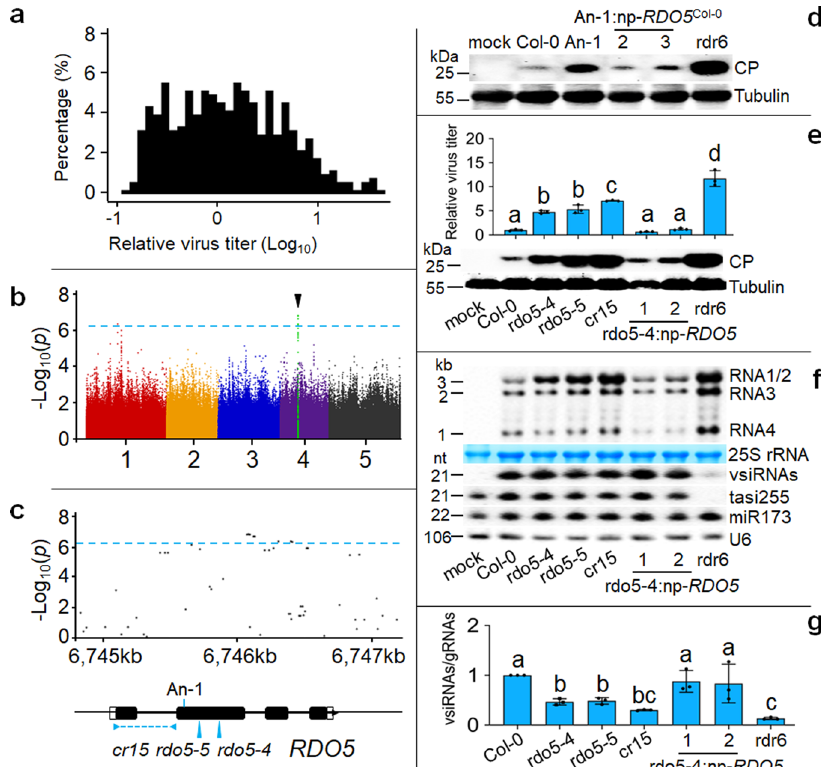
Fig. 1 RDO5 confers quantitative virus resistance. a A nearly normal distribution of CMV- Δ 2b accumulation levels in 496 Arabidopsis accessions after ELISA readings at 2 weeks post-infection were log-transformed. b Manhattan plot for GWAS mapping of the quantitative resistance phenotype to CMV- Δ 2b infection. Five A. thaliana chromosomes were depicted in different colors. The horizontal dash-dot line corresponds to the signi fi cance threshold ( p = 5.48 × 10 − 7 ). The black tringle above the threshold indicates the most signi fi cantly associated locus. c Regional Manhattan plot (from 6745 kb to 6747 kb), structure of RDO5 , and positions of T-DNA insertion alleles ( rdo5-4 and rdo5-5 ), CRISPR/Cas9 deletion allele ( cr15 ) and the single base pare deletion in accession An-1. d Western detection of viral coat protein (CP) accumulation in An-1 and two RDO5 -complemented lines. Detection of tubulin alpha chain was shown as loading control. e , f ELISA and Western detection ( e ) of viral CP accumulation with the titer in Col-0 set as 1 and Northern detection ( f ) of CMV- Δ 2b genomic RNAs 1-3 (gRNAs), subgenomic RNA4 and vsiRNAs as well as endogenous miRNA 173 (miR173) and trans-acting siRNA 255 (tasi255) in wild-type (Col-0), rdo5 mutants and complemented lines. 25 S rRNA was stained and U6 RNA probed on the same membrane as loading controls. g Ratios of vsiRNAs/gRNAs were calculated from Phosphor-imager readings of Northern hybridization signals in ( f ) with the ratio in Col-0 set as 1. The experiments in ( d ) and ( f ) were repeated three times independently with similar results. Data presented are means ± SEM from three replicates ( e ) or independent experiments ( g ), letters indicate signi fi cant differences (one-way ANOVA, Duncan, p < 0.05) and black dots represent the individual values. The source data underlying blots in ( d ), ( e ) and ( f ), ELISA data in ( e ) and ratio data in ( g ) are provided as a Source Data fi